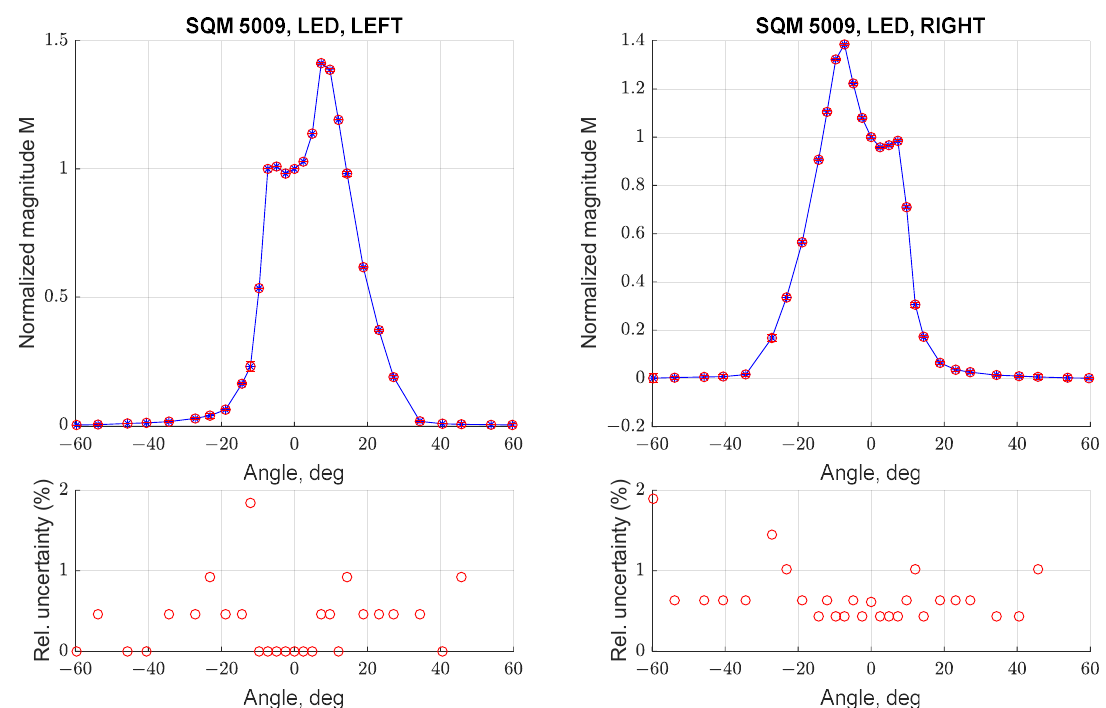
Figure 9. Normalized angular response curve ( top ) and relative uncertainty (1 σ , bottom ) for three scans performed with SQM-LE 5009 (RIGHT and LEFT).